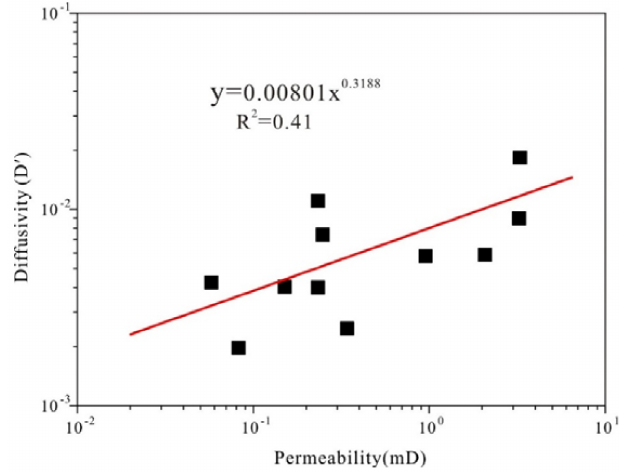
Figure 6. Diffusivity ( D (cid:48) ) vs. permeability for the different rank coals.